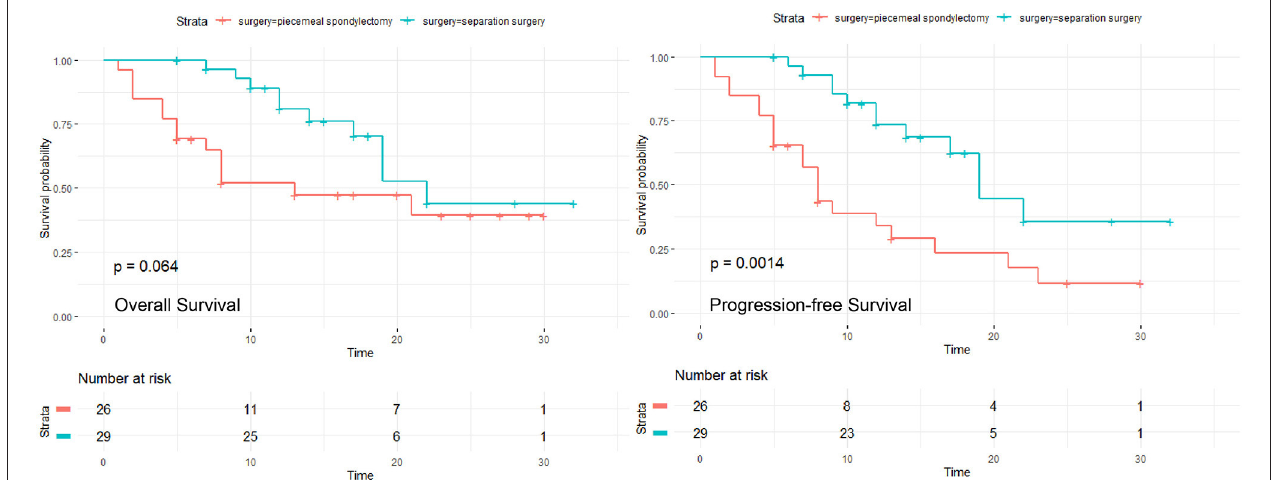
FIGURE 3 | Comparisons of OS and PFS between piecemeal spondylectomy and separation surgery.